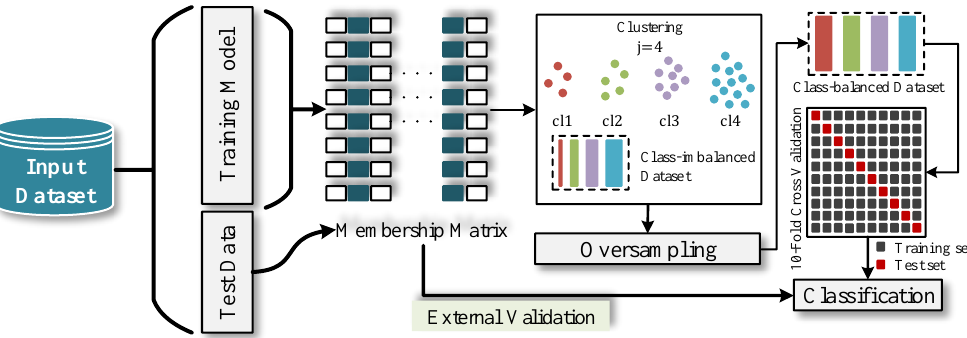
Figure 1. The architecture of the voice pathology detection (VPD) system using machine